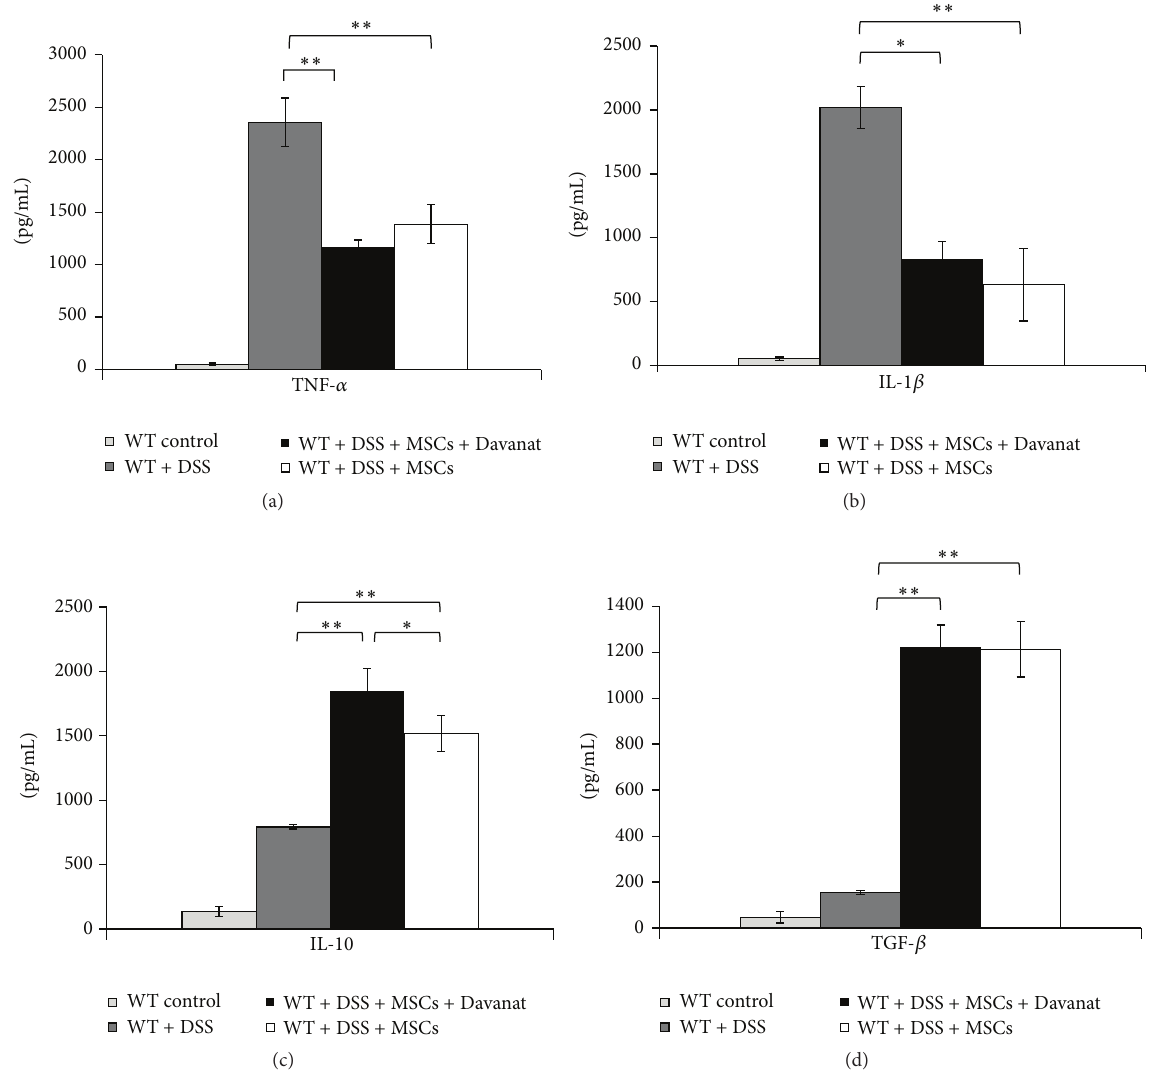
Figure 2: Pharmacological inhibition of Gal-3 in MSCs results in increased concentration of IL-10 in sera of DSS-treated animals. Levels of proinflammatory cytokines in the sera are shown: (a) TNF- 𝛼 and (b) IL-1 𝛽 . Levels of anti-inflammatory cytokines in the sera are shown: (c) IL-10 and (d) TGF- 𝛽 . Values are mean ± SEM ( 𝑛 = 10 per group). ∗ 𝑃 < 0.05 , ∗∗ 𝑃 < 0.01 .